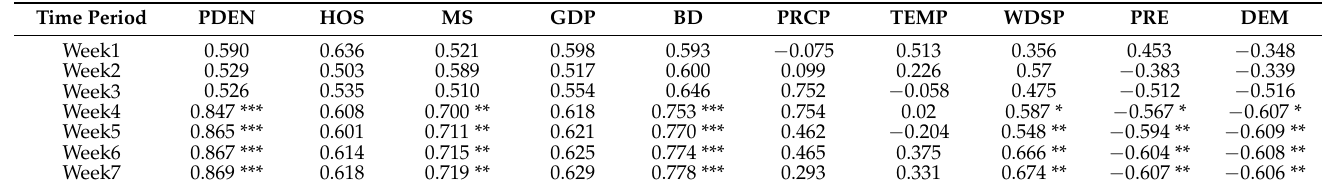
Table 2. Pearson correlation coefficients between IFR and risk factors in Hubei province.